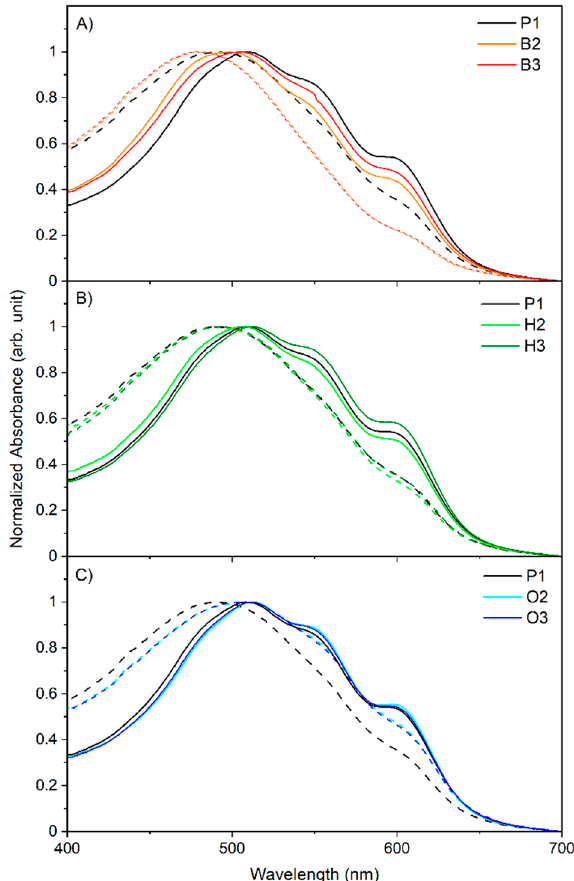
Figure 4. UV-Vis spectra of ( A ) B2, and B3; ( B ) H2, and H3; and ( C ) O2, and O3 triblock copolymer films blended with PCBM before annealing (dashed lines), and after annealing (solid lines). In all figures, same UV-Vis spectra of P1 copolymer films are depicted together with other spectra for better comparison.